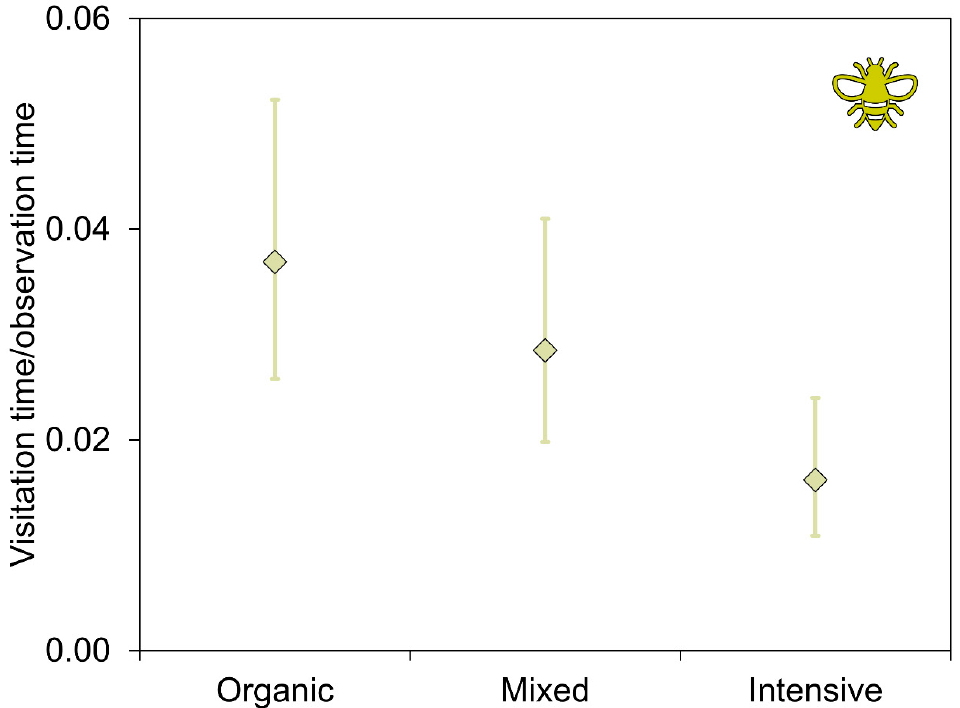
Figure 3. Estimated marginal means and 95% CI for the predictor chemical use based on a generalized linear mixed model with the ratio pollinator visitation time over total observation time as dependent variable. Data are collected on 42 fields in the municipalities of Cipaganti and Pangauban (West Java)